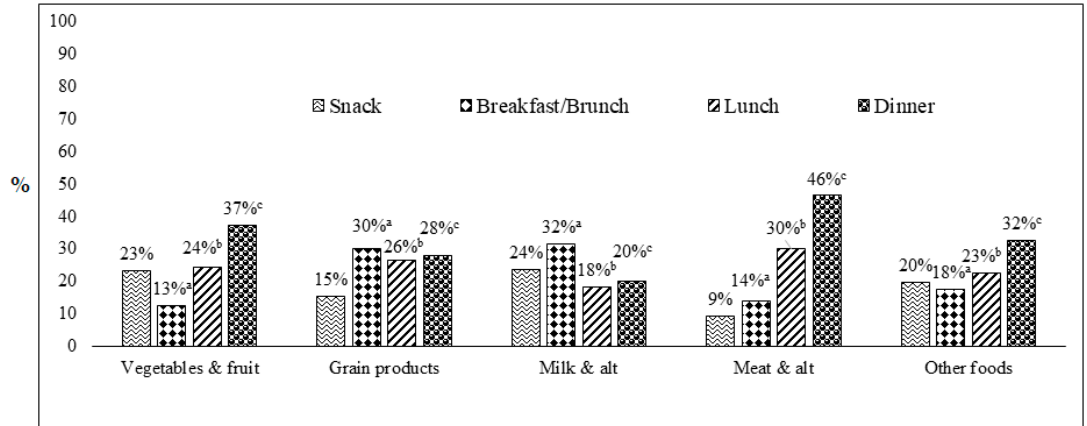
Figure 2. Percentages of food group consumption at various meal occasions ( n = 26,896,800) (i.e., snack, breakfast/brunch, lunch, dinner) among snack consumers 1 .Data source: 2015 Canadian Community Health